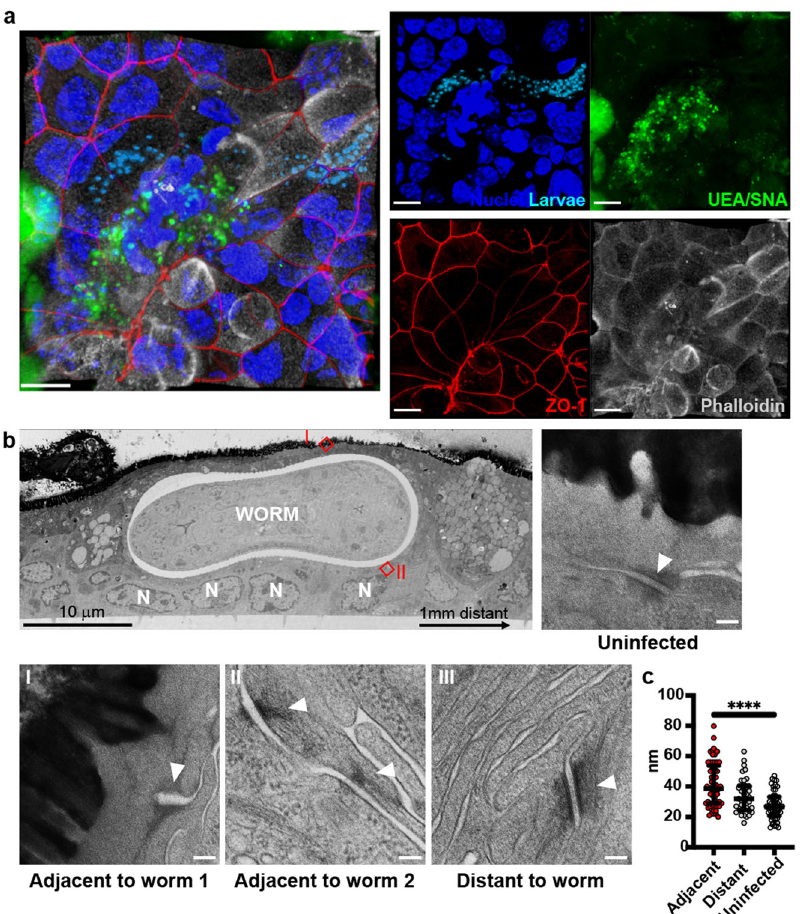
Fig. 7 Perturbations on desmosomes, but not on tight junctions, in host cells of whipworm larvae during early infection of caecaloids. a Z-stack projection of confocal IF images of T. muris L1 larva in syncytial tunnel in caecaloids infected for 24 h. In blue and aqua, DAPI stains nuclei of IECs and larvae, respectively; in green, the lectins UEA and SNA bind mucins in goblet cells; in red, ZO-1 protein binds tight junctions; and in white, phalloidin binds to F-actin. Scale bars 10 μ m. IF imaging experiments on T. muris- infected caecaloids were done in triplicate across two independent replicas using three caecaloid lines derived from three C57BL/6 mice. b Representative TEM images of transverse sections of T. muris- infected caecaloids (72 h p.i.) and desmosomes (arrowheads) joining infected and adjacent cells (insets I and II), cells 1 mm distant to the worm from infected caecaloids (inset III), and cells from uninfected caecaloids. Scale bars for desmosome images 100 nm. c Desmosome separation in nm was measured in uninfected cells, cells distant from those infected and host cells from four independent worms. Measurements adjacent n = 62, distant n = 37 and uninfected n = 50. Data are presented as median values with interquartile range. **** p < 0.0001 Kruskal Wallis test and Dunn ’ s comparisons among groups. Source data are provided as a Source data fi